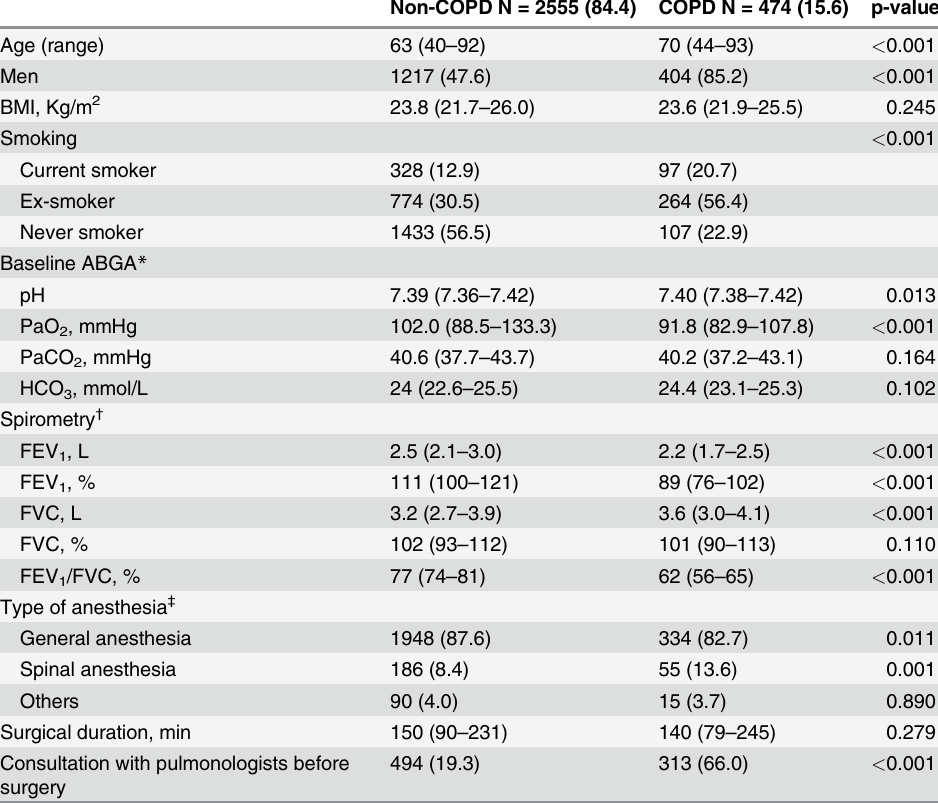
Table 1. Baseline